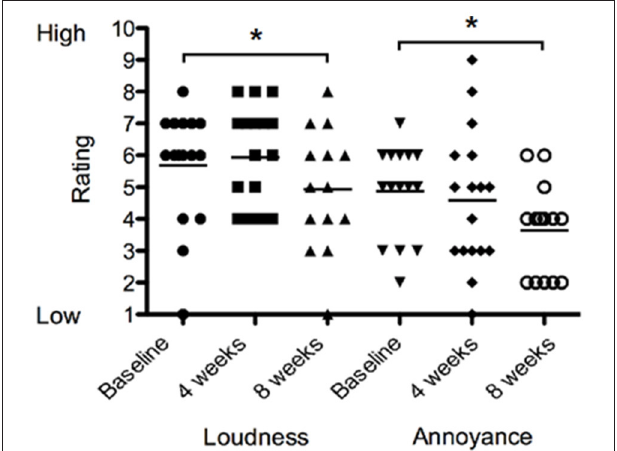
FIGURE 7 | Tinnitus loudness ratings (on a scale of 1–10, where 1 corresponded with very quiet tinnitus and 10 with extremely loud tinnitus) and annoyance ratings (on a scale of 1–10, where 1 corresponded low in distress and/or annoyance and 10 with extremely high distress) of participants at baseline (filled circles for loudness ratings; inverted triangles for annoyance ratings), at 4 weeks follow-up (squares for loudness ratings; diamonds for annoyance ratings) and at 8 weeks follow-up (triangles for loudness ratings; open circles for annoyance ratings). Significant differences are indicated by * p < 0.05. Horizontal lines represent average rating scores.